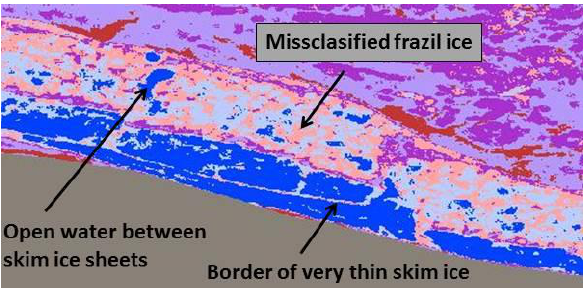
Figure 7. River ice type on 08.12.2013 (km 210.5 - km 212.5) based on TerraSAR-X